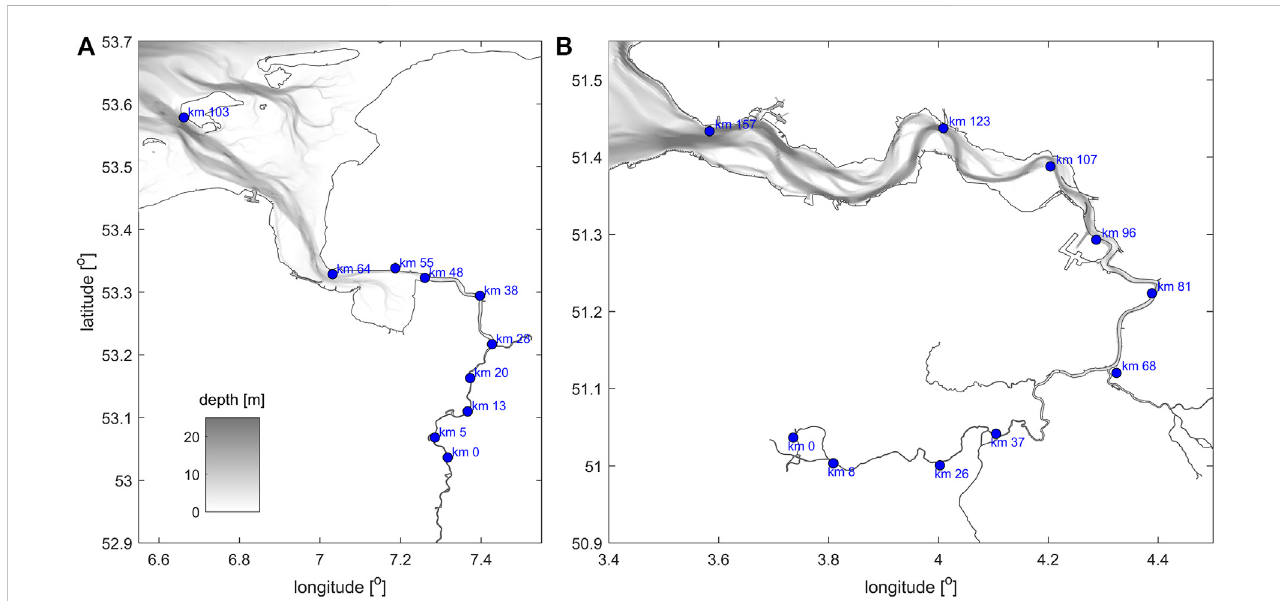
FIGURE 3 Gauging stations in the Ems Estuary (A) and Scheldt Estuary (B) , with bathymetry in meter below local reference datum (NAP). The Ems Estuary has been deepened between km 0 and its mouth at km 103. The Scheldt estuary has been deepened between km 81 and 157, and sand mining took place between km 68 and